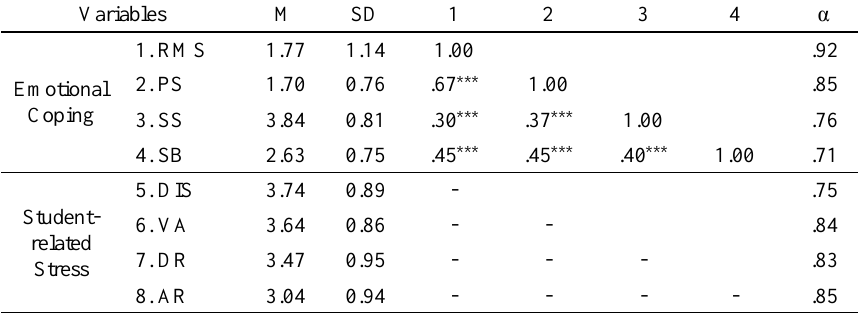
Means, standard deviations, reliabilities, and correlations of research